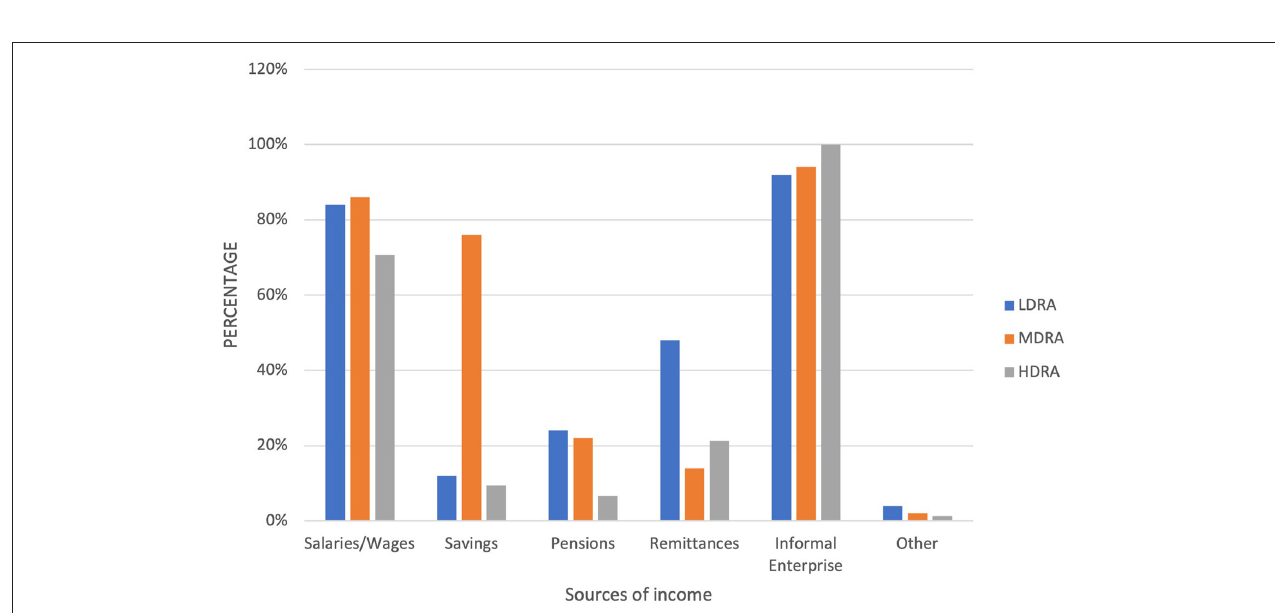
FIGURE 3 | Responses on the multiple sources of income of households in the three different residential areas. Source: Field survey (2018).